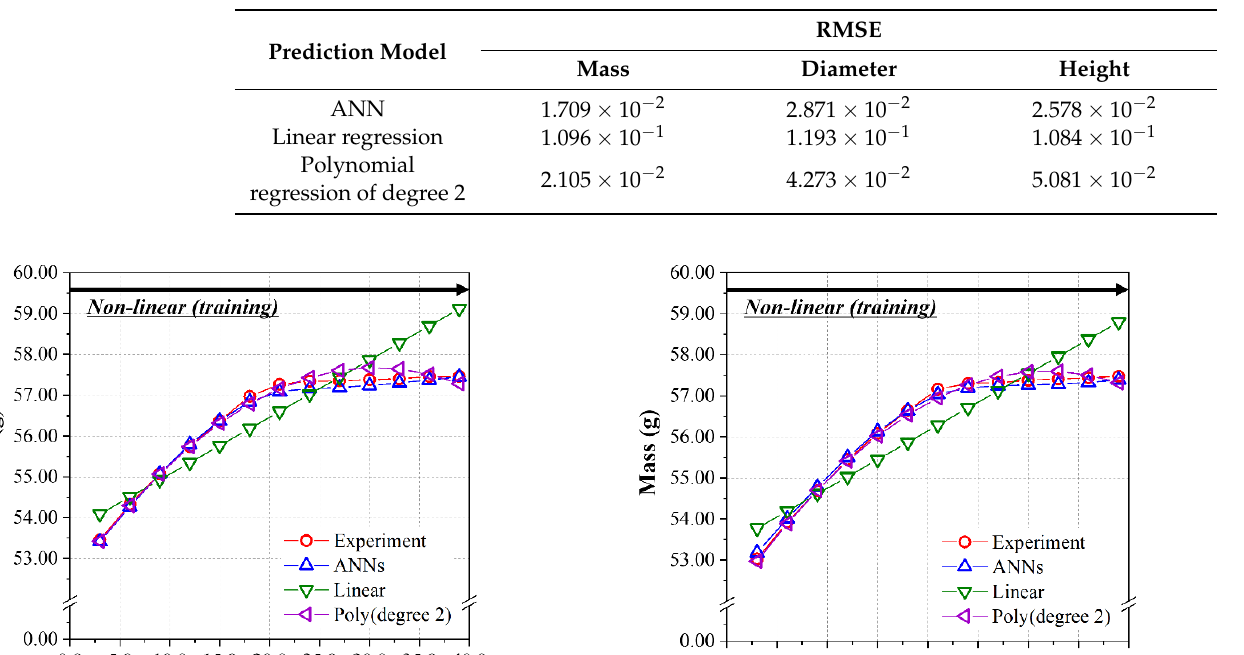
Table 13. Root mean square errors (RMSEs) of normalized Table A2 (packing time was 3.0~39.0 s) for prediction models learned by the nonlinear group (packing time was 3.0~39.0 s).